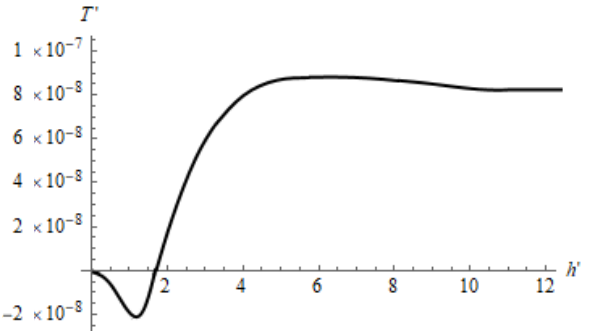
Figure 10. Tangential force as a function of the layer thickness. E 1 / E 2 = 10 − 3 , ν 1 = 0.48, ν 2 = 0.3,